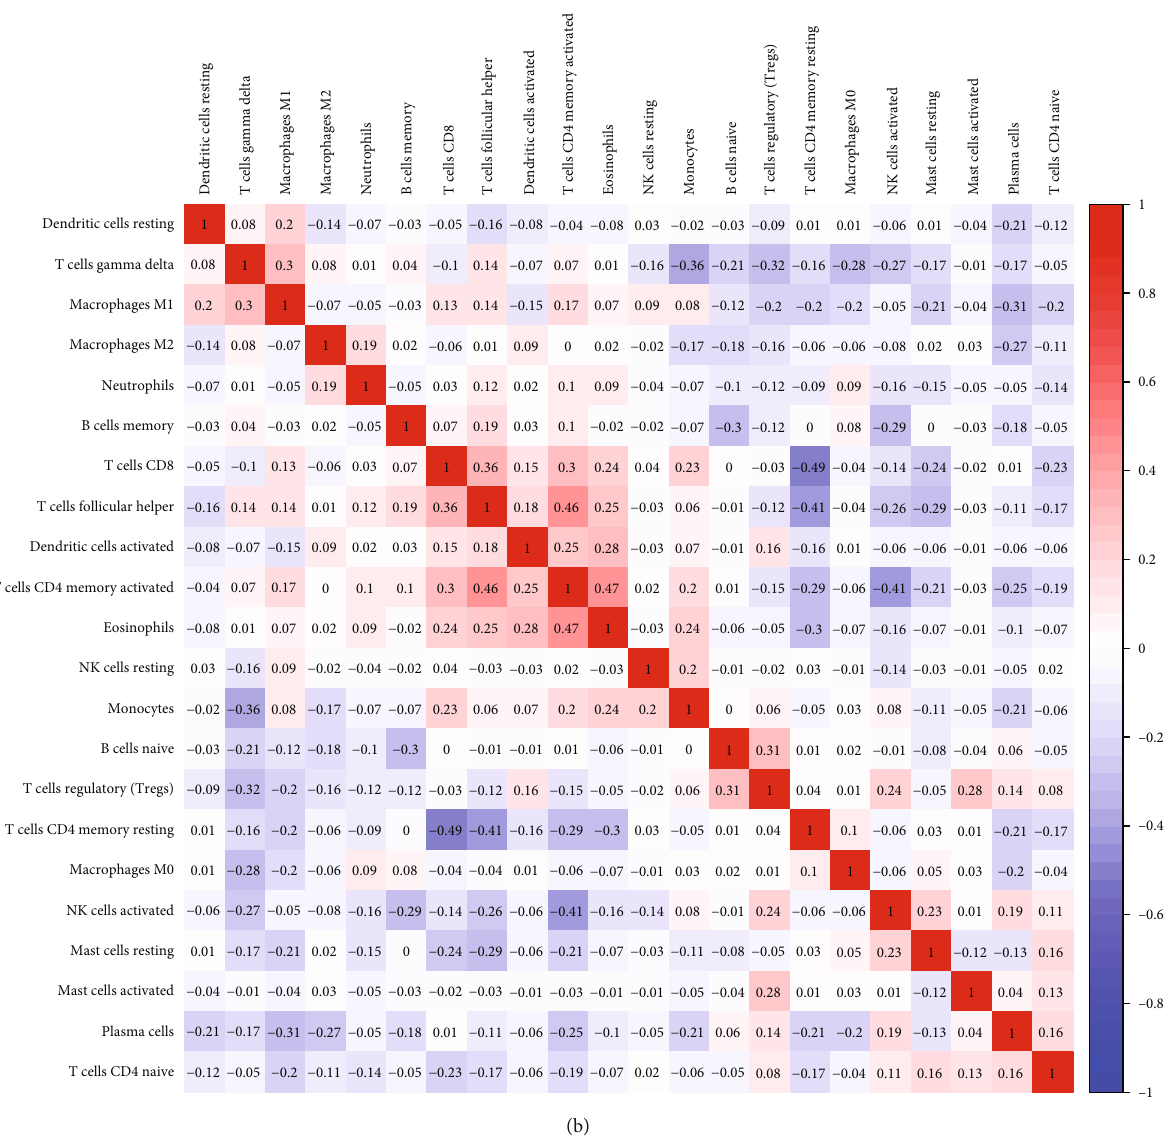
Figure 6: According to CIBERSORT, the proportion of in fi ltrating immune cells. (a) The total number of immune cells found in each sample is reported. (b) A heat map was constructed to illustrate the link between the 21 di ff erent types of immune in fi ltrate cells that were identi fi